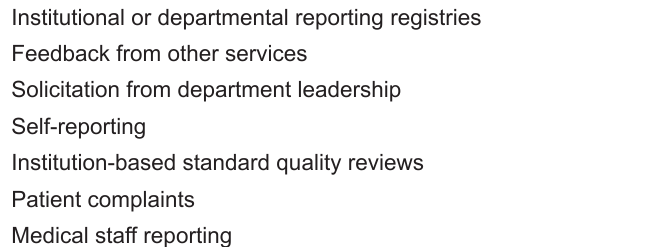
Table 4. Potential sources for case identification with regard to medical error